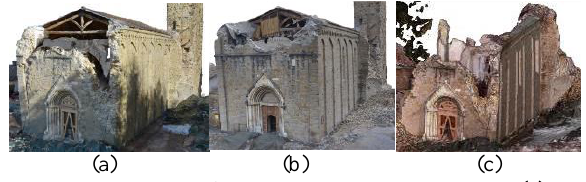
Figure 6. A view of the achieved models: September (a), December (b), January (c)